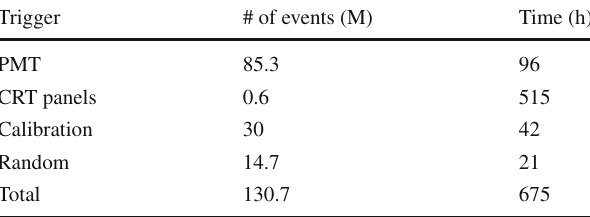
Fig. 5 ExampleofascintillationlighteventinaProtoDUNE-DPPMT at a gain of 10 7 in LAr without electric field Table2 Summaryoftriggerconditionsindicatingthenumberofevents and total time of data taken in the different trigger configurations